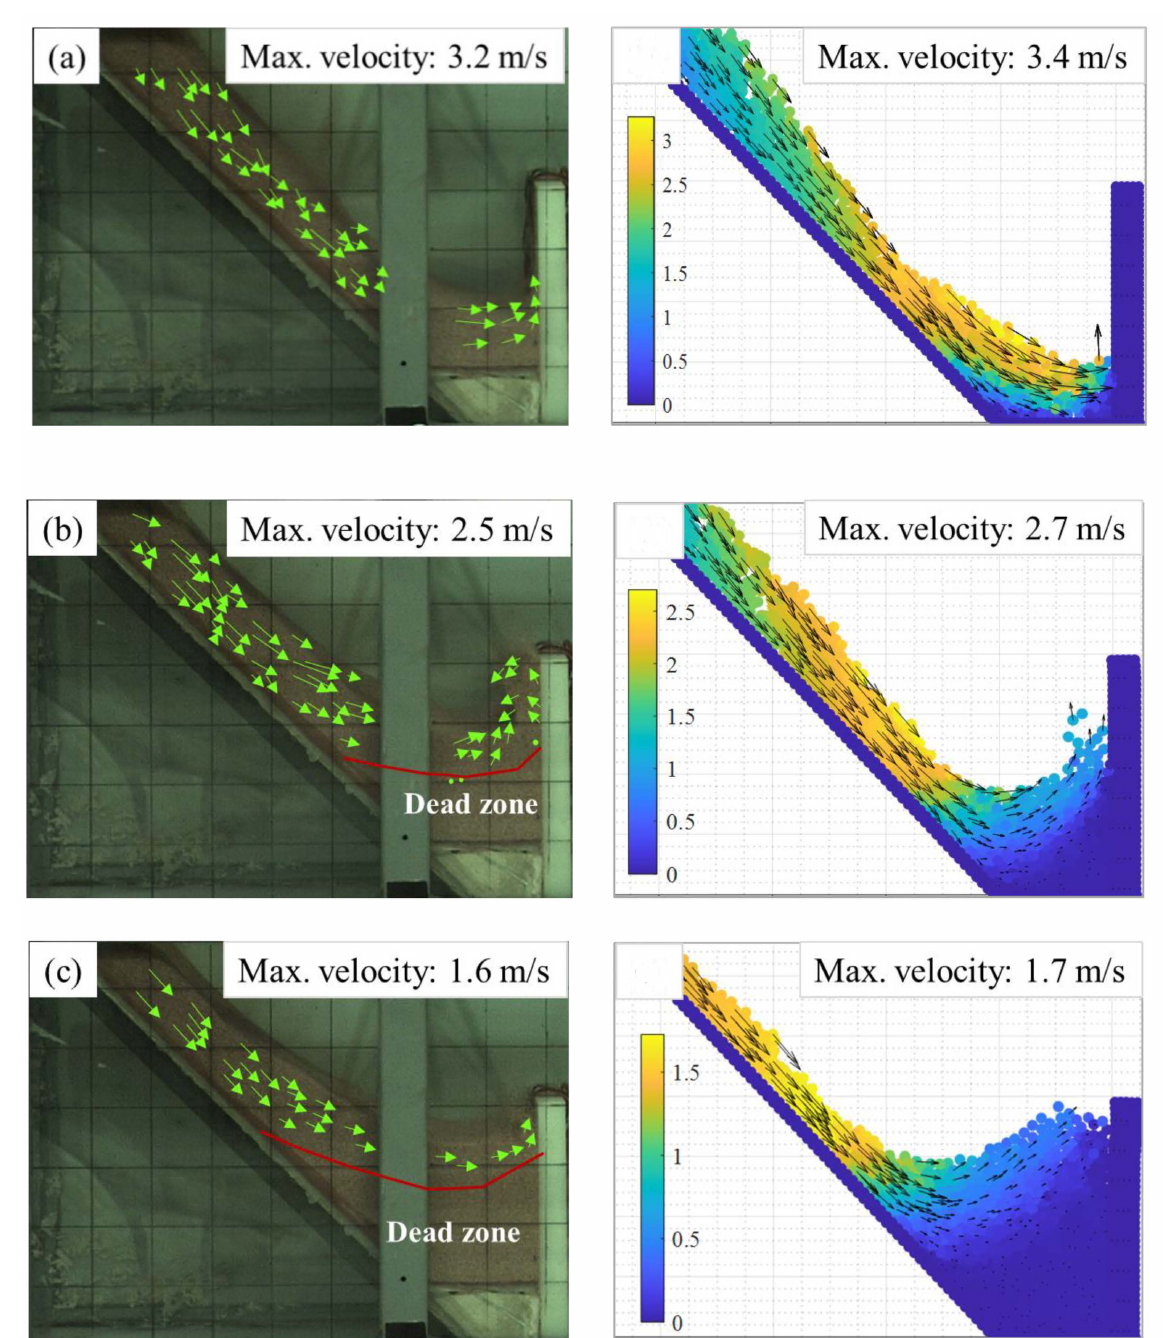
Figure 3. Comparison of impact kinematics at different times (test ID: P_15/S_10): ( a ) t = 0.00 s, ( b ) t = 0.11 s, ( c ) t = 0.50 s; the velocity field of flows through PIV (left); computed flow kinematics through SPH